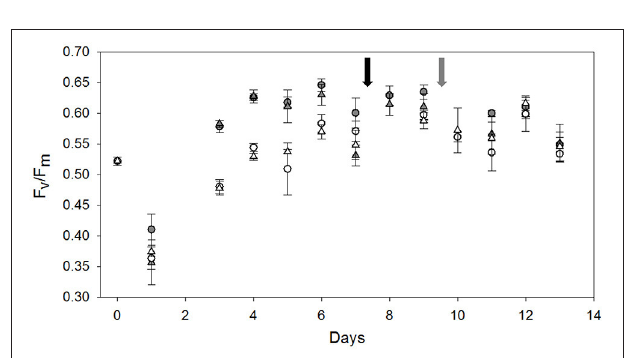
FIGURE 3 | Development of the dark-acclimated photosynthetic quantum efficiency (F v /F m ) in LL LC (gray circles), LL HL (gray triangles), HL LC (open circles), and HL HC (open triangles) treatments over the course of the experiment ( n = 3, errors bars indicate 1 s.d.). The arrows indicate the time of dilution for LL (black) and HL (gray)